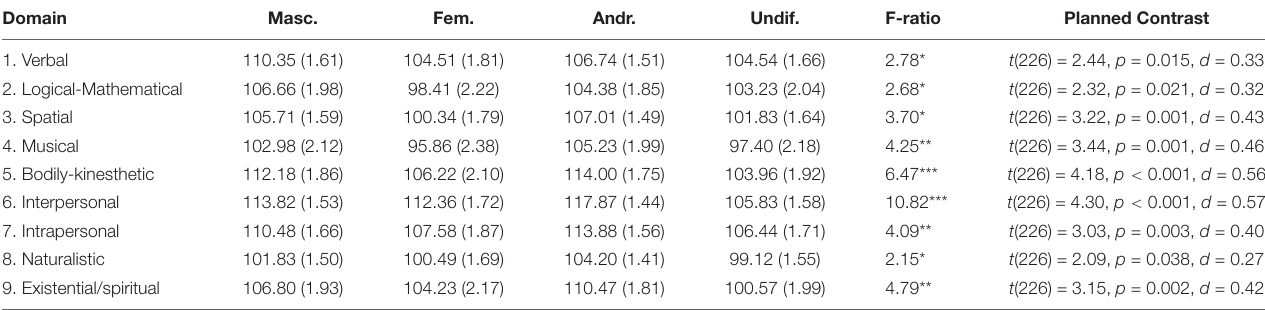
TABLE 5 | Sex-role differences in self-estimated multiple intelligences.